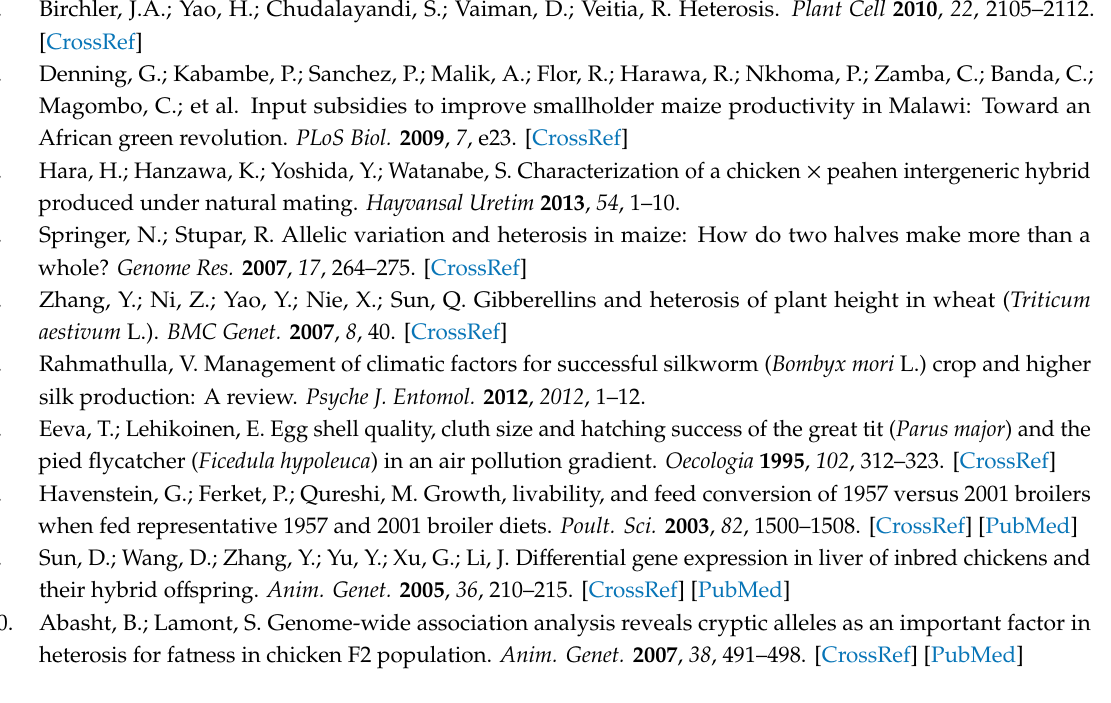
Figure S1: Pictures of chickens used in this experiment; Figure S2: Principal component analysis (PCA) for the four groups; Figure S3: KEGG pathway analysis of high- / low-parent dominant and under-dominant genes for RC and CR groups: ( A , B ) high-parent dominant genes, ( C , D ) low-parent dominant genes, and ( E , F ) under-dominant genes; Table S1: Classification of gene expression patterns in reciprocal crosses; Table S2: Primers for genes used in qRT-PCR; Table S3: Summary statistics for transcriptome sequencing data; Table S4: Summary statistics for gene expression patterns in reciprocal crosses; Table S5: KEGG pathway analysis of over-dominant genes for the RC and CR groups: ( A ) RC group, ( B ) CR group; Table S6: Detailed information of over-dominant genes in the RC and CR groups: ( A ) RC group, ( B ) CR group; Table S7: Detailed information of overlaps for over-dominant genes between the RC and CR